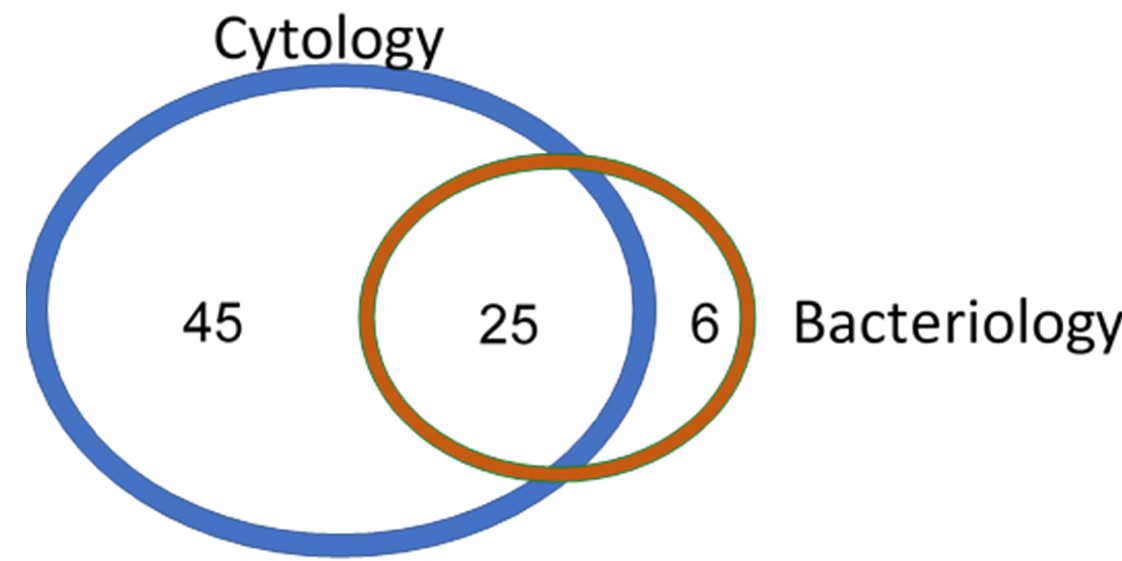
Figure 1. Venn diagram of the distribution of cows based on their cytology (≥6% of PMNL) and bacteriology results (VBLAB; reference test).